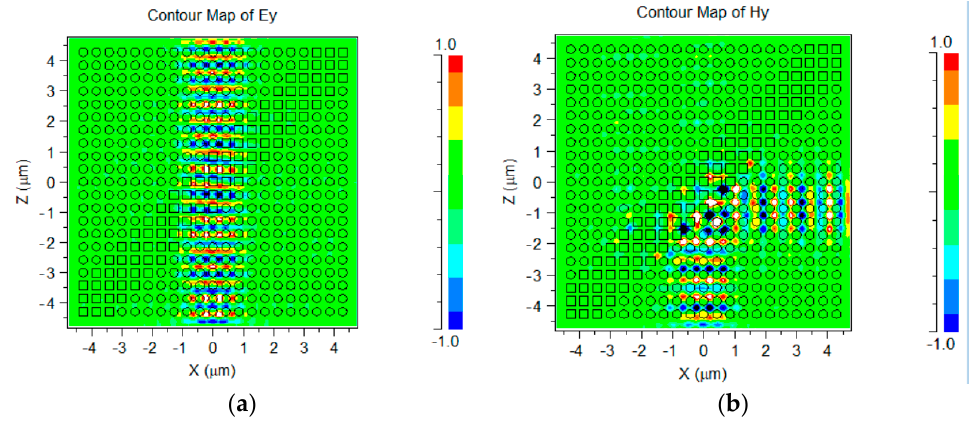
Figure 8. At 1550 nm, when n is 5 ( a ) steady-state field distribution in TE mode; ( b ) steady-state field distribution in TM